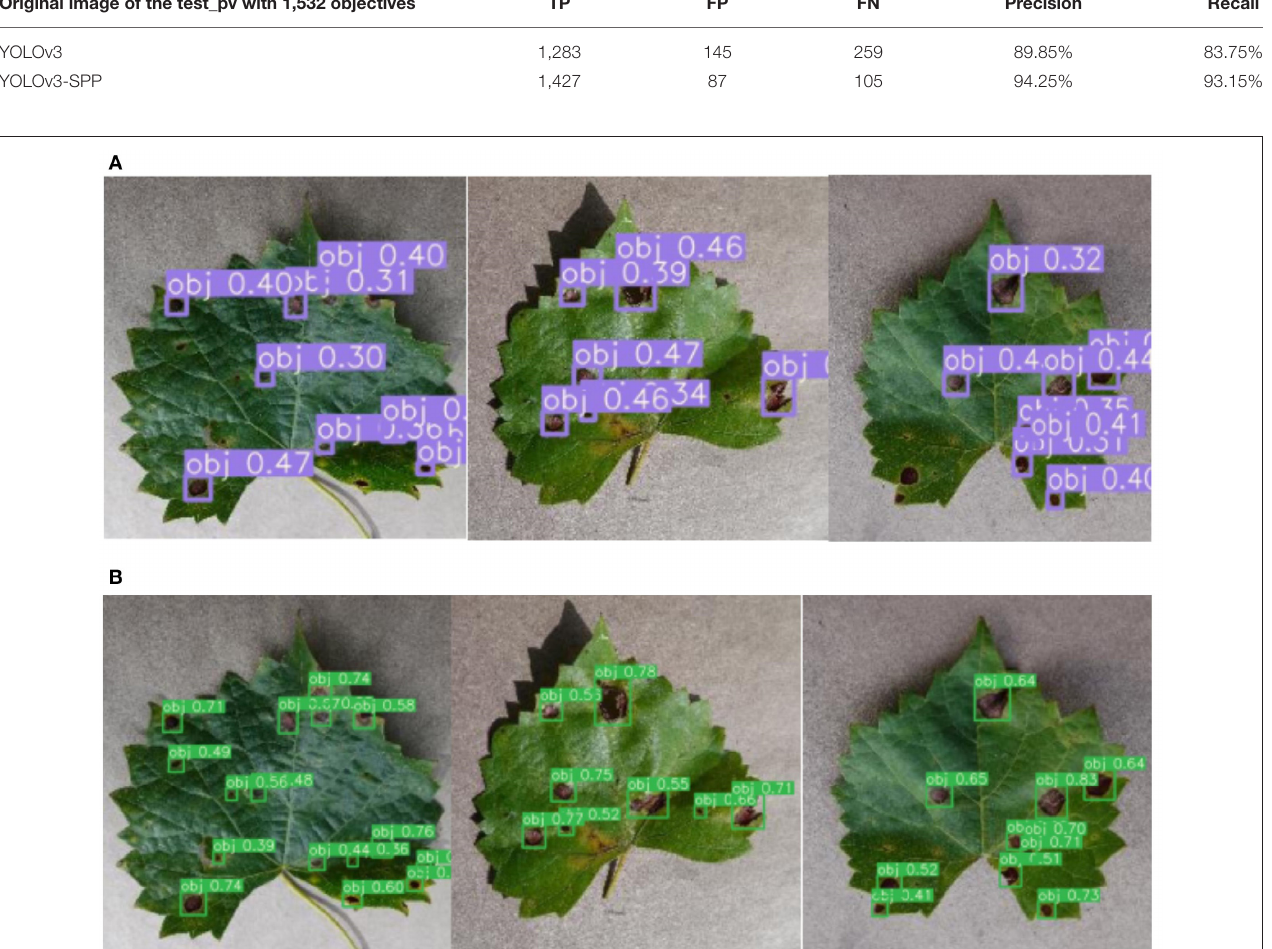
105, which was 154 less than that of YOLOv3. The proposed YOLOv3-SPP achieves the detection accuracy of 94.25% and a recall of 93.15%. These results are 4 and 9% higher than the original YOLOv3,